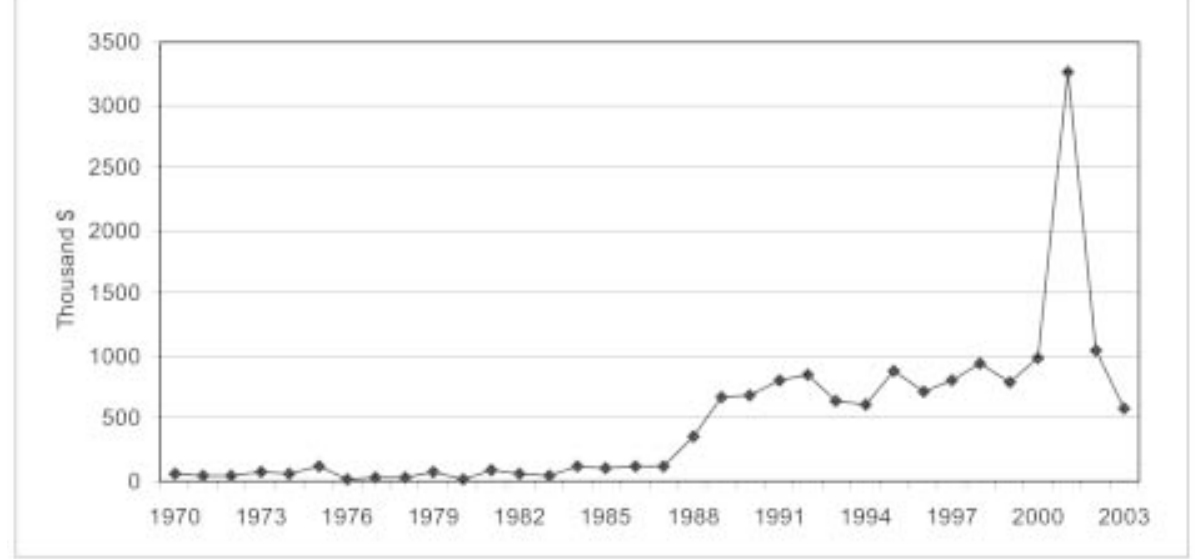
Source: UNCTAD, World Investment Report, 2004. Fig 1 . Trend of FDI inflows in Turkey between 1970–2003